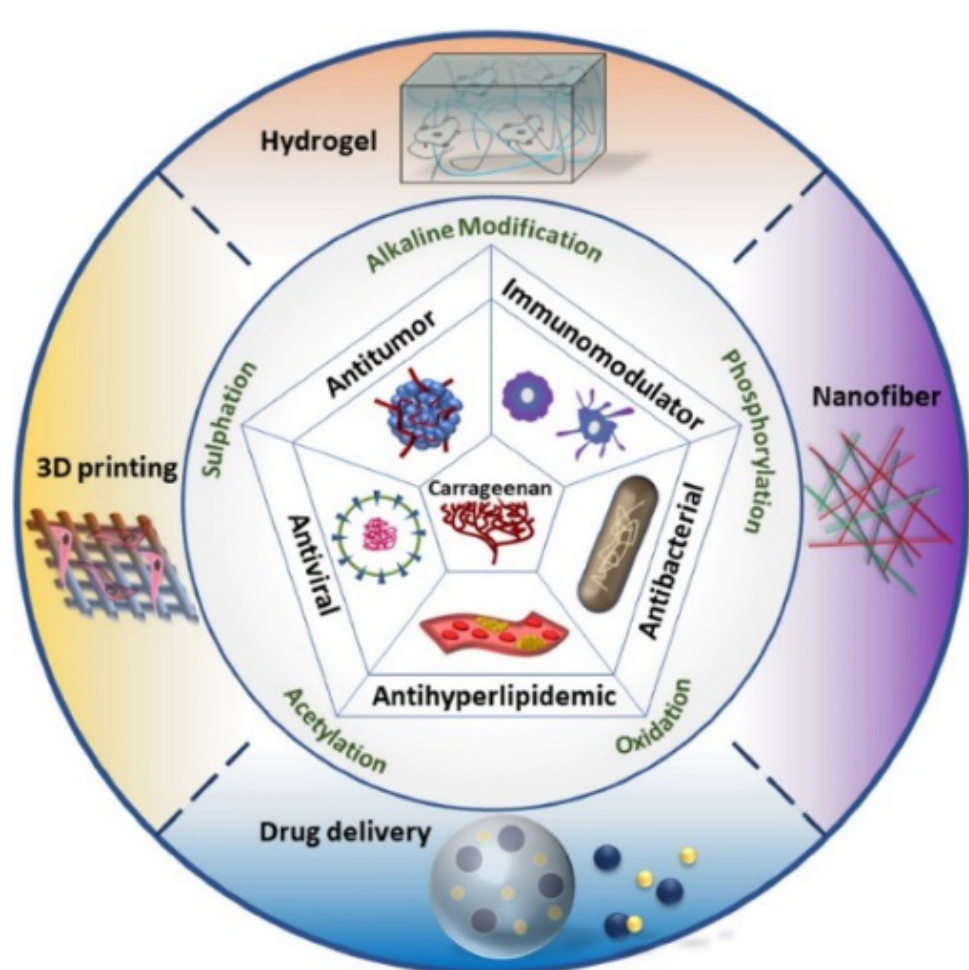
Figure 3. Applications of carrageenans in tissue engineering and regenerative medicine. Reproduced from Ref. [209], Copyright © 2021 Elsevier Ltd. All rights reserved with permission of Elsevier.